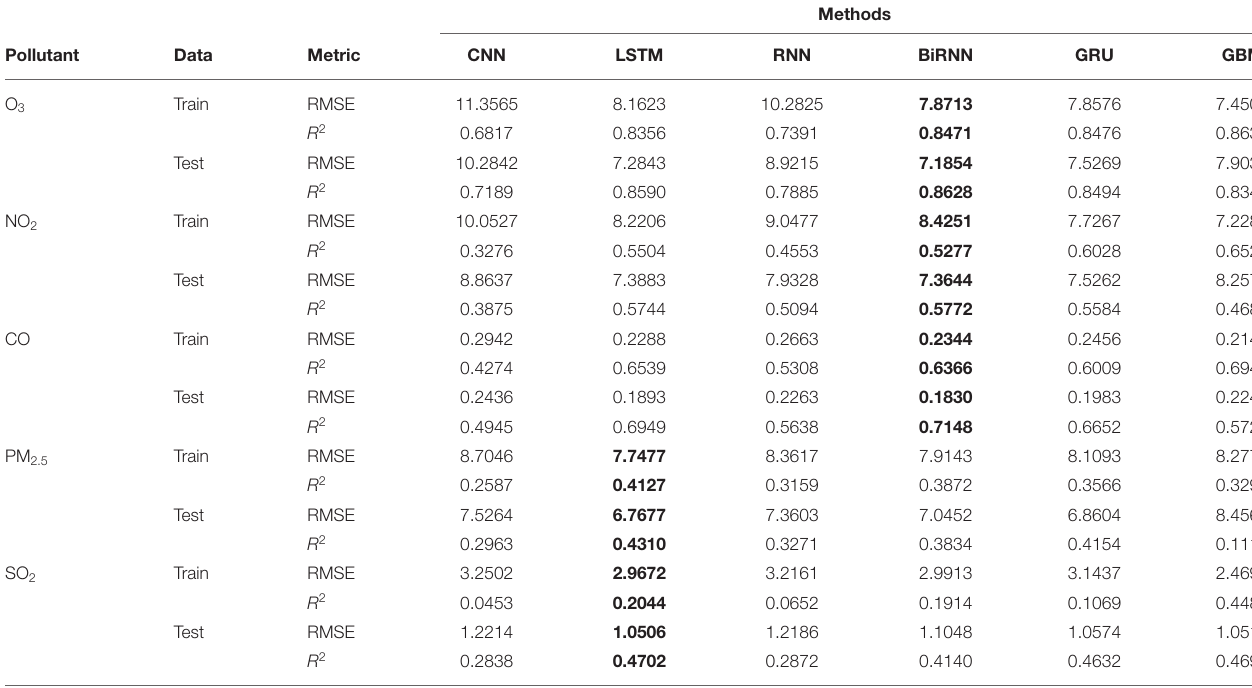
TABLE 4 | Performance of GBM and five DL models for evaluation period.